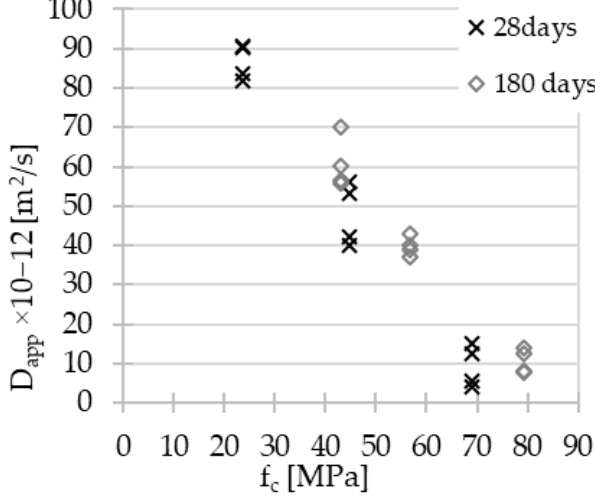
Figure 8. AACs’ chloride diffusion coefficient values vs. fc.